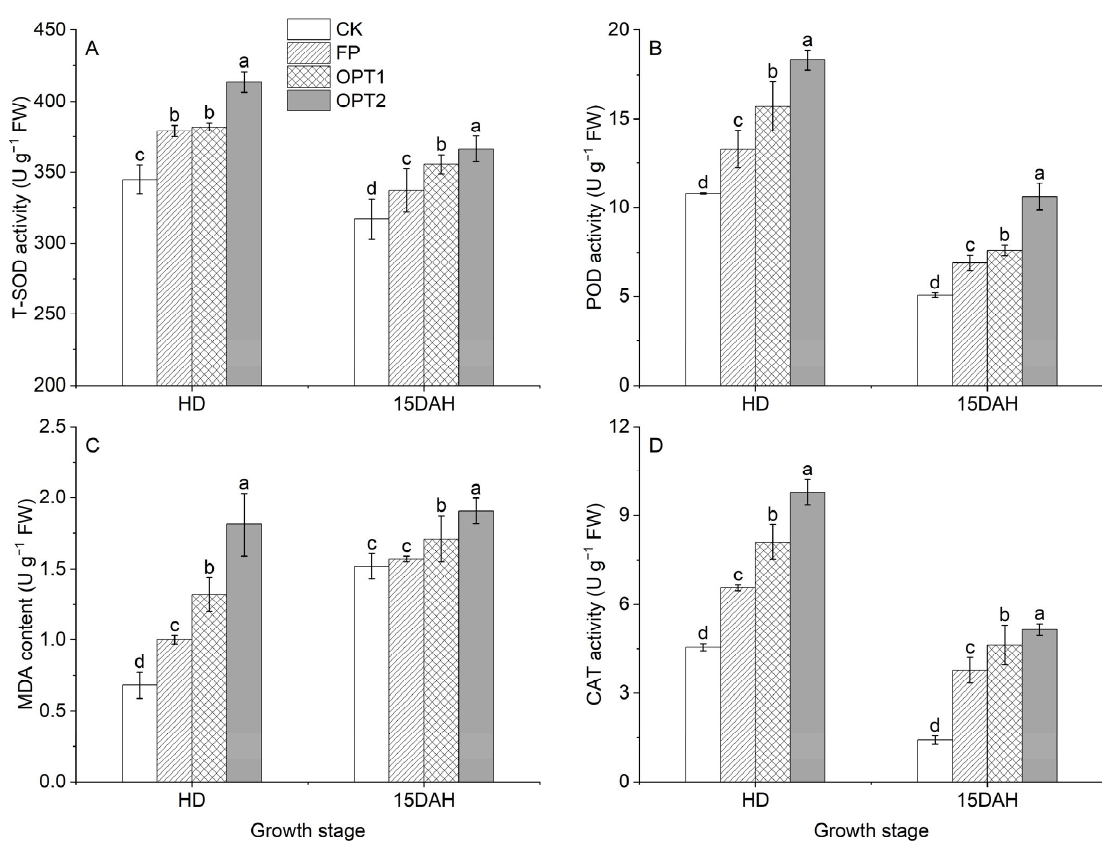
Figure 8. The Leaf protective enzyme system including T-SOD ( A ), POD ( B ), MDA ( C ) and CAT ( D ) under four management systems at HD and 15DAH. Means followed by the same letter do not significantly differ (LSD, p < 0.05).